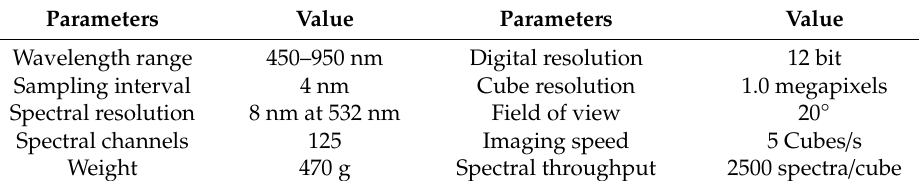
Table 2. Main parameters of the UHD S185 (provided by the manufacturer).